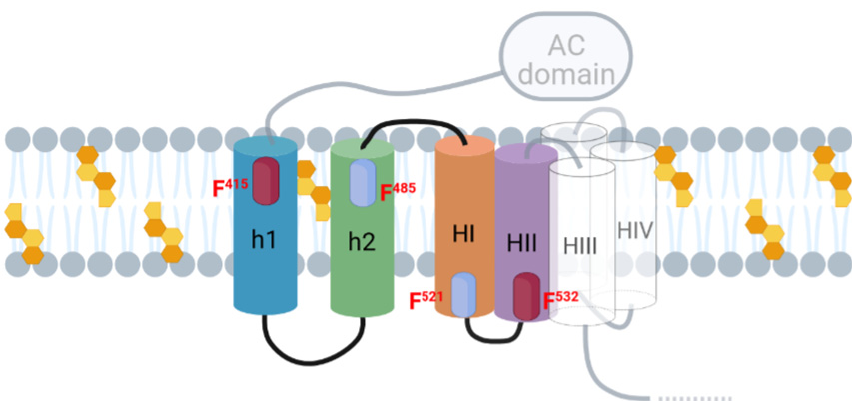
Figure 12. Schematic model of the membrane topology for the translocation region and the pore- forming domain. The figure shows a scheme of the putative membrane topology for the h1, h2 (TR region) and HI-HV (pore-forming domain) helices involved in AC translocation and in building the ACT pore structure as proposed here. Original picture created with BioRender.com.